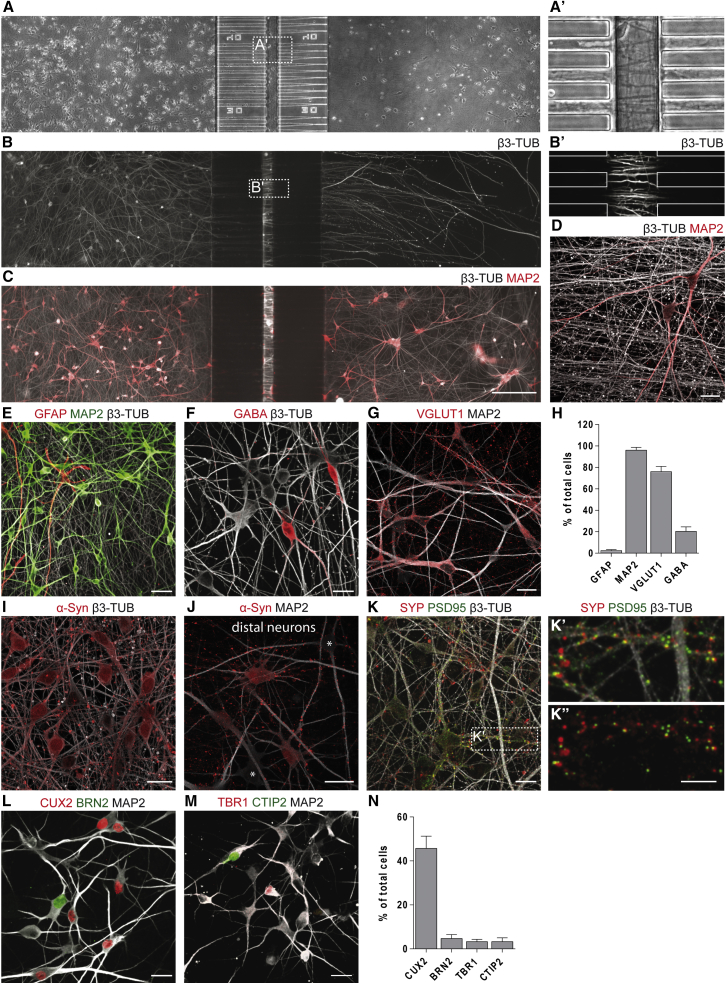
Characterization of hiPSC-Derived Corticocortical Neuronal Networks(A) Phase-contrast stitched image of hiPSC-derived neuronal networks 30 days post-plating. (A') Inset of central chamber invaded by axons.(B–D) (B and C) Fluorescence images (white, β3-tubulin [β3-TUB]; red, MAP2) of hiPSC-derived neurons in the proximal chamber projecting their axons into the distal chamber (B) in the absence or (C) in the presence of target neurons. (B′ and D) Higher-magnification images showing (B′) axons crossing the central chamber of the microchannel compartment and (D) axon bundles exiting the microchannel in the distal chamber.(E–H) Representative images and quantification of astrocytic (GFAP) and neuronal (MAP2, β3-TUB, GABA, VGLUT1) marker expression. (E) GFAP, MAP2, β3-TUB; (F) GABA, β3-TUB; (G) VGLUT1, MAP2; (H) percentage of cells expressing each marker.(I and J) (I) Expression of α-Syn in nuclei and perikarya of neurons (asterisks point out negative cells) and enrichment in synaptic boutons (J, distal chamber).(K–K″) (K) Identification of putative excitatory synapses by juxtaposition of pre- (red, SYP) and post- (green, PSD95) protein complexes along neurites (white, β3-TUB). (K′) Magnification of box indicated in (K).(L–N) Representative images and quantification of a repertoire of distinct cortical neuronal markers. (L) CUX2, BRN2, MAP2; (M) TBR1, CTIP2, MAP2; (N) percentage of cells expressing each marker.Data are shown as mean ± SEM; n = 3. Scale bars: 200 μm in (A–C), 20 μm in (A′, B′, and D), 40 μm in (E), 20 μm in (F, G, and I–M), 10 μm in (K′ and K″).